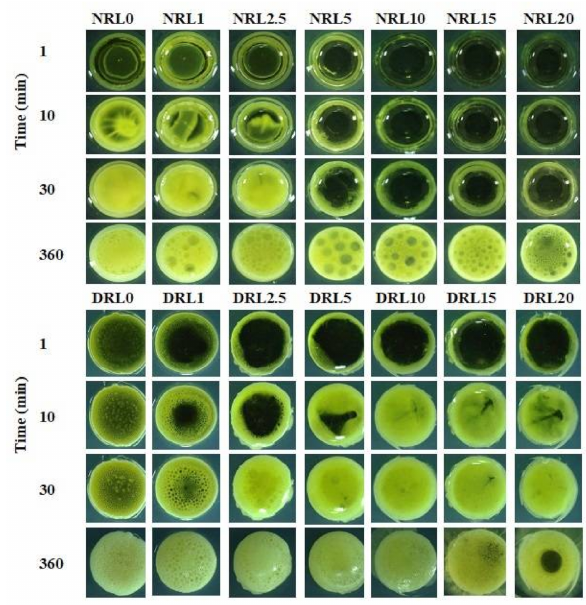
Figure 2. The gel formation of drug-free rosin-based in situ forming gel with various LO concentra- tions in agarose gel with different time intervals by microscopic observation using a stereomicroscope at magnification of ×